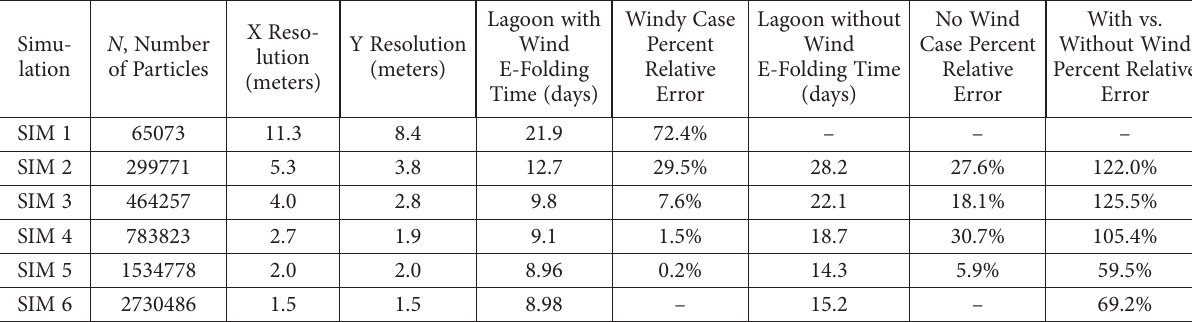
Table 2. Variation of the e -folding times as a function of the number of particles. The X and Y resolutions are the initial distances between individual particles in x and y directions. The percent relative error calculations take the solution of the simulation with larger number of particles as truth. The “Windy” case is taken as truth in “With vs. Without Wind” error calculations Simu-